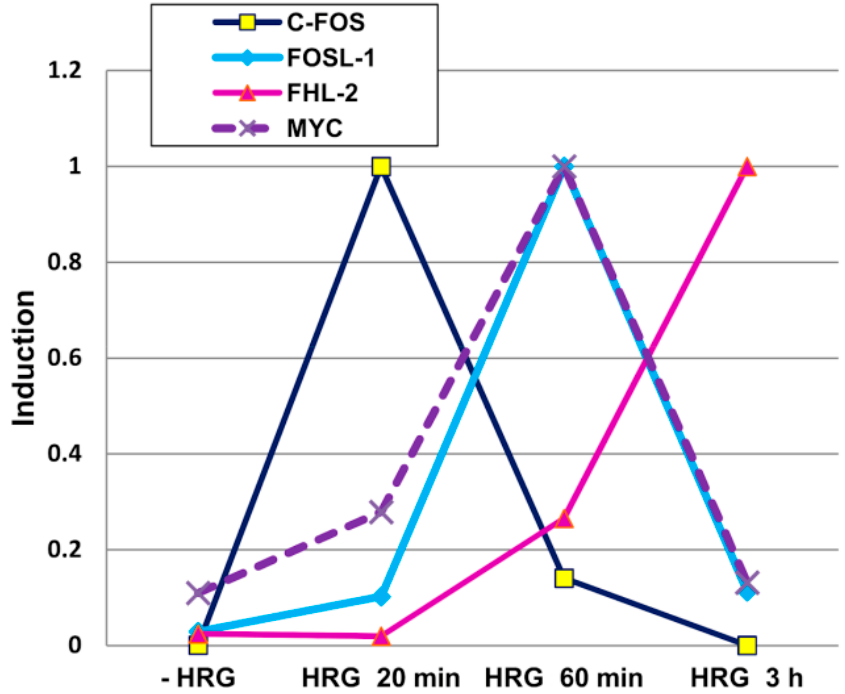
Figure 5. qPCR evaluation of the transcription in the dynamics of HRG treatment. Biphasic expression of the early response genes tested at four time points and presented in relation to the maximum averaged expression (1 unit on Y -axis) of each of the four tested genes. Representative graphs of two independent experiments. (Note: This figure and a slightly modified figure legend were originally published under CC-BY license in [41]).